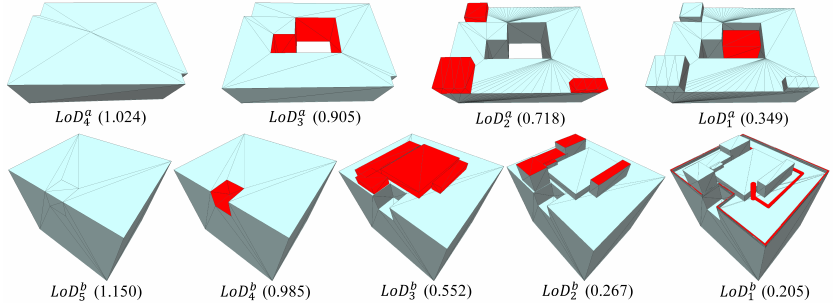
Figure 12. Tested models with different LODs. The numbers shown below the models represent the shape similarities between the models and their corresponding point